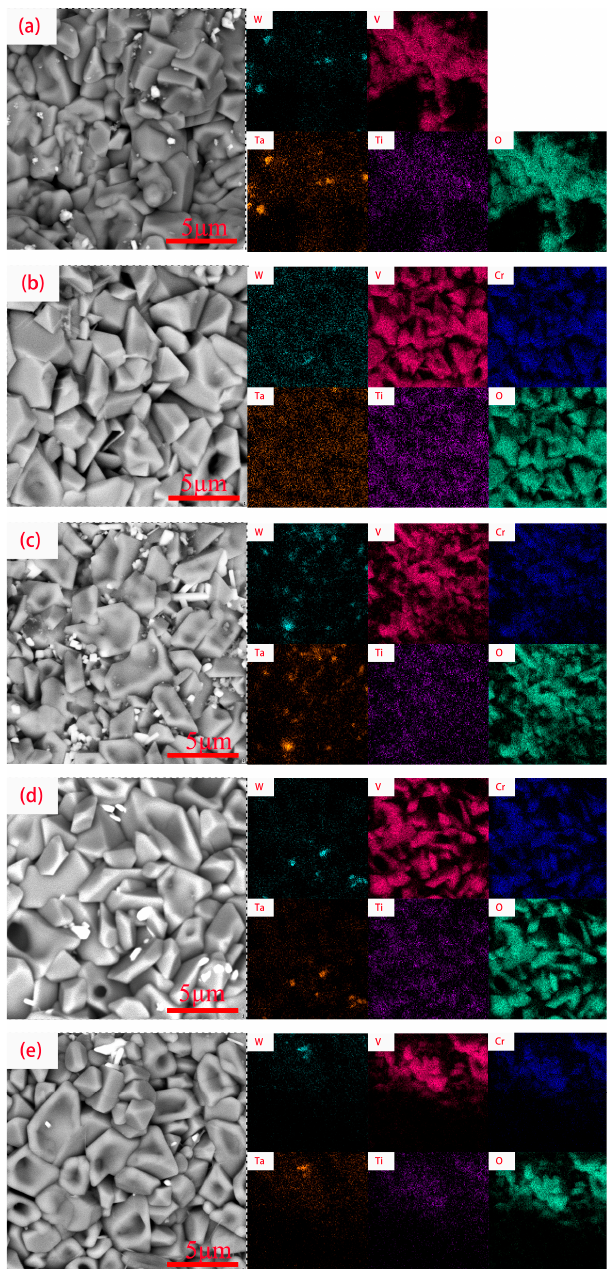
Figure 8. EDS element analysis of oxidation surface of WVTaTiCr x RHEA coating: ( a ) Cr 0 ; ( b ) Cr 0.25 ; ( c ) Cr 0.5 ; ( d ) Cr 0.75 ; ( e ) Cr 1 .